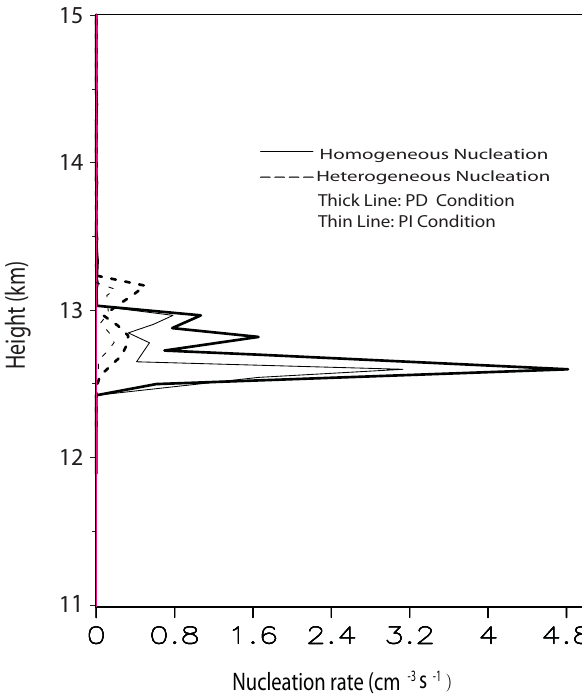
Fig. 5. Vertical distribution of the time- and area-averaged homo- geneous and heterogeneous nucleation